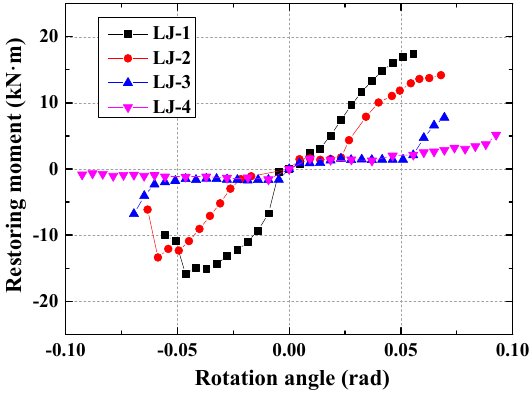
Figure 22. Skeleton